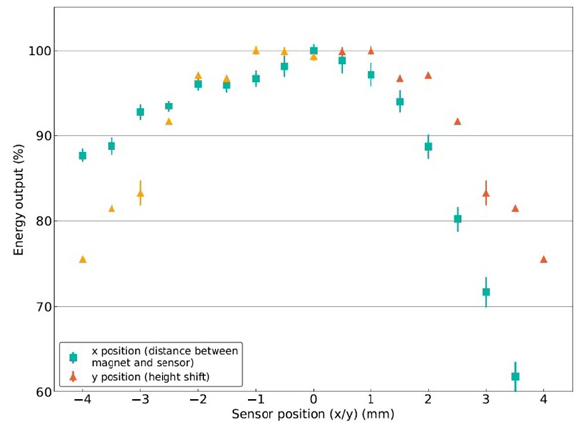
Figure 5. Mounting tolerances of the magnets with respect to the Wiegand generator. Error of sensor position is within the symbols. Table 1. Comparison of rectifier performance for various configu- rations and diode